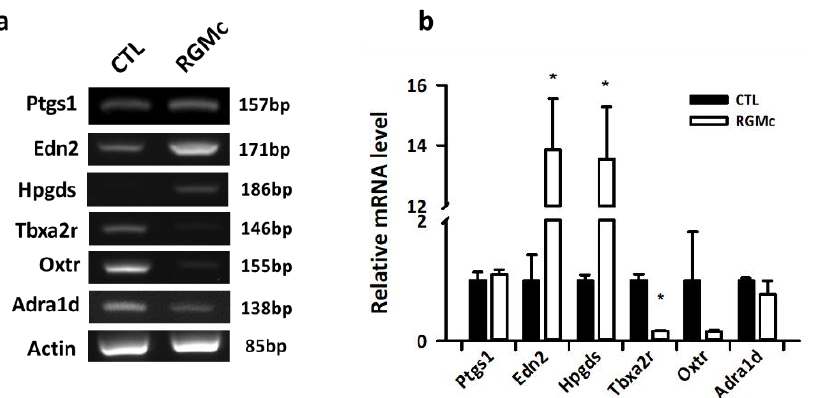
Figure 6. Quantitative real-time PCR analyses to validate the NGS data in RGMc-treated ovaries. ( a ) RT-PCR analysis of Ptgs1 , Edn2 , Hpgds , Tbxa2r , Oxtr , Adra1d , and β -actin expression in control (CTL) and RGMc-treated ovaries. ( b ) Quantitative real-time PCR analysis of Ptgs1 , Edn2 , Hpgds , Tbxa2r , Oxtr , and Adra1d expression in control (CTL) and RGMc-treated ovaries normalized against β -actin expression. * p < 0.05 versus the control group.